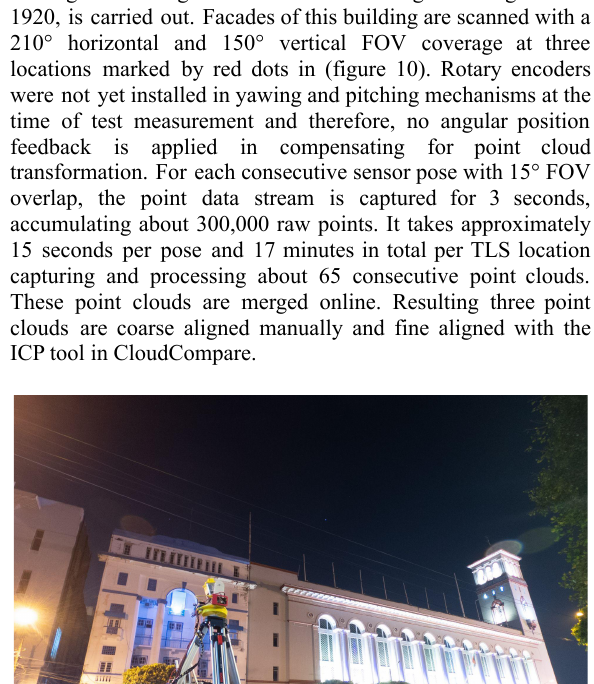
Figure 8. ACSC calibration target